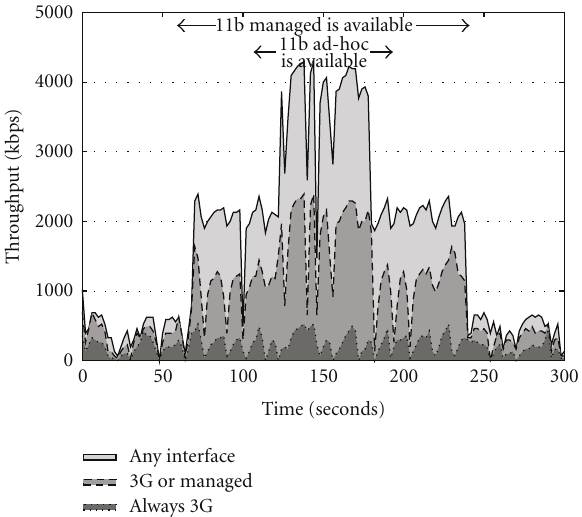
Figure 16: RTT between MNNs with three background TCP